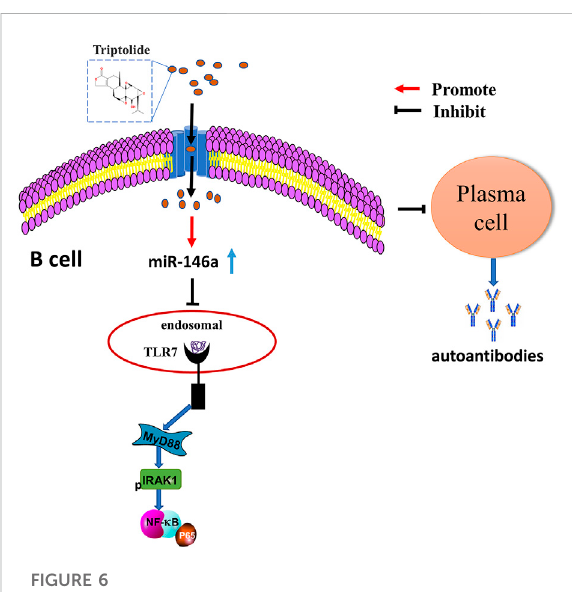
The underlying mechanism wherein TP affects the differentiation of B cells into plasma cells by regulating miR-146a to inhibit the TLR7/NF- κ B signaling